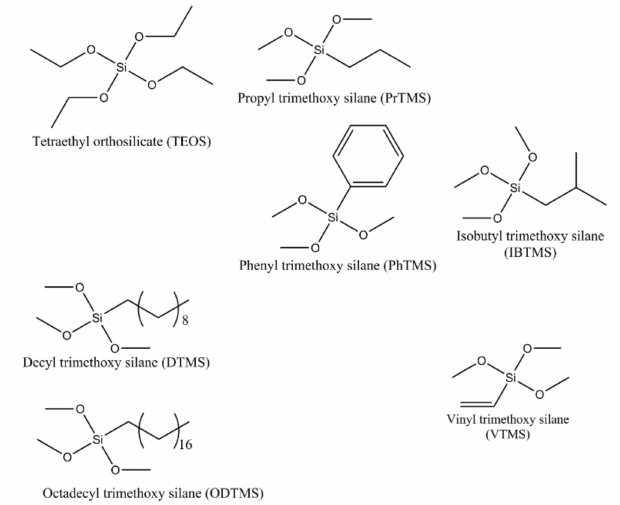
Figure 3. Molecular structure of the used